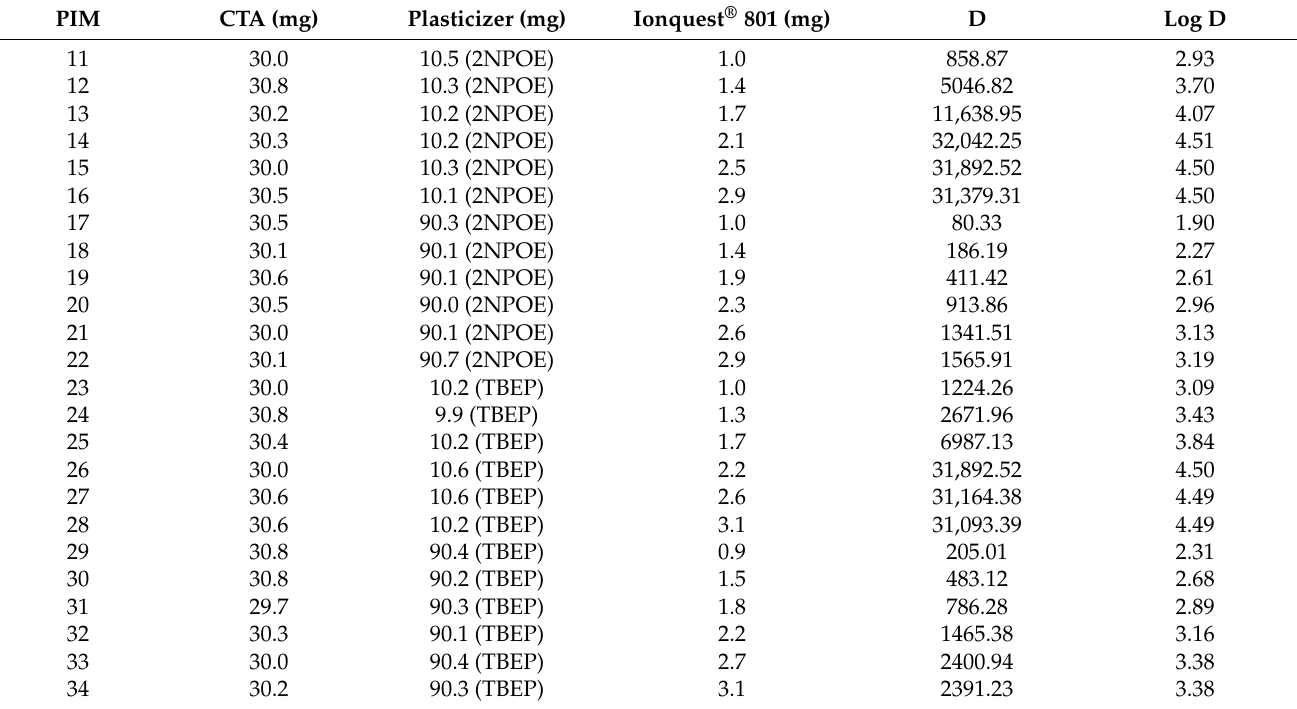
Table 1. PIM compositions and results of the study of the extraction equilibria by liquid–solid